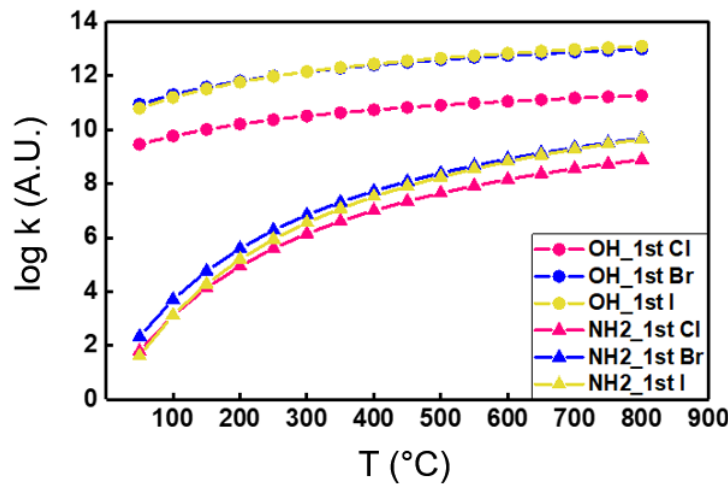
Figure 6. The reaction rate constants for Ti halide precursors first ligand dissociation on –OH, NH 2 functionalized Si surfaces at different temperatures.